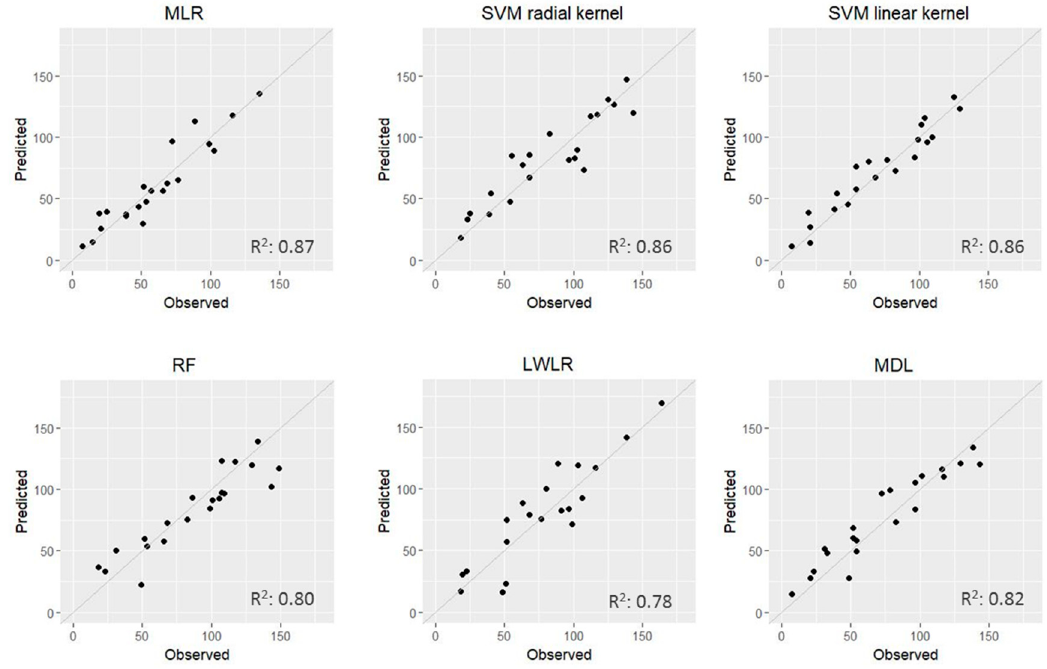
Figure 3. Scatterplot of predicted vs. observed values of total biomass (TB) (tons/ha) using different regression methods. Table 4. Summary of the models and validation results in terms of RMSE (tons/ha), %RMSE, and bias (tons/ha). SVM r. refers to Support Vector Machine with radial kernel; SVM l. refers to Support Vector Machine with linear kernel; ret. is returns.